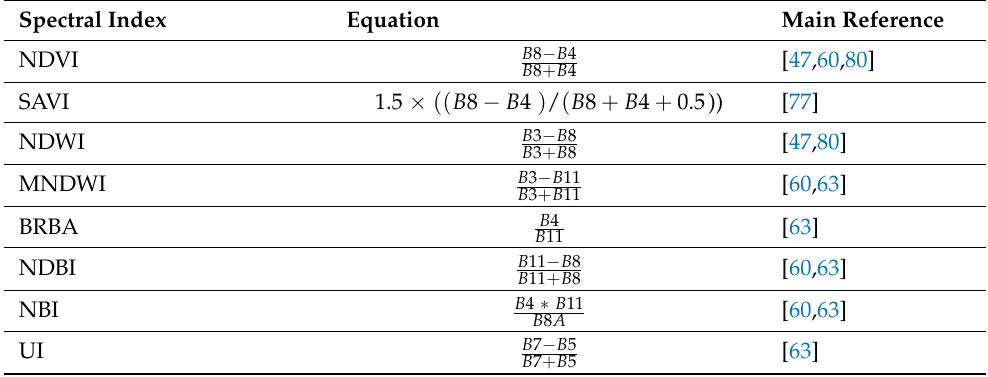
Table 2. Spectral indices selected for